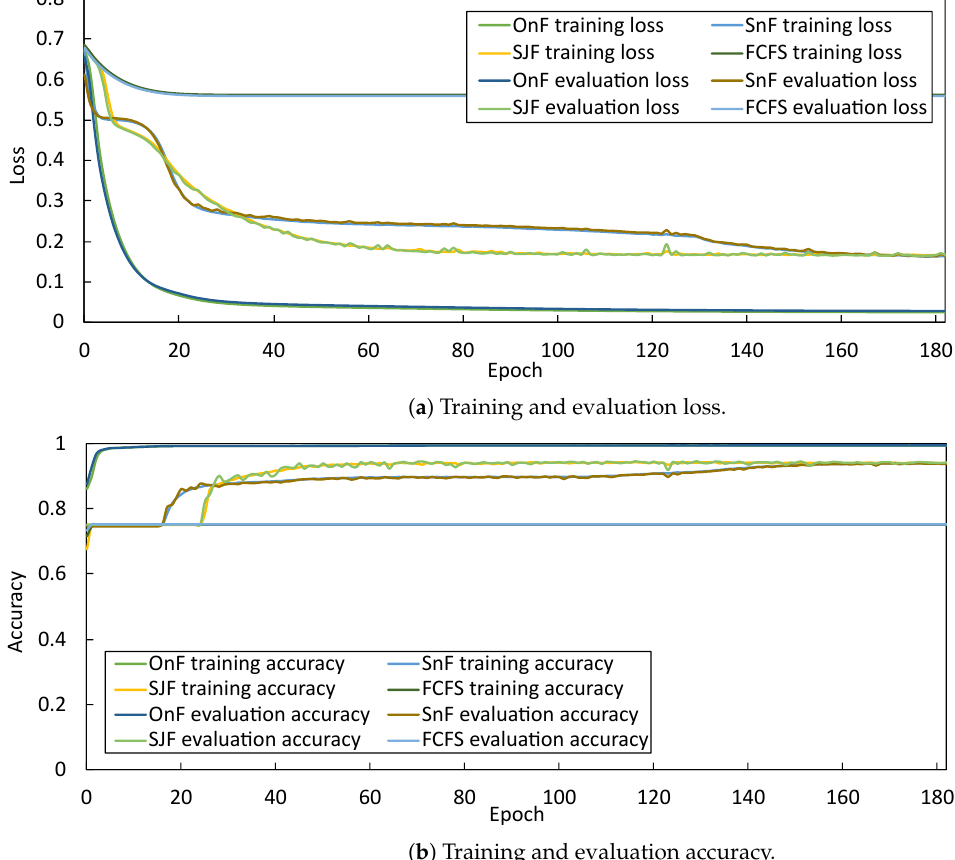
Figure 7. Plotted loss and accuracy from the post-training log on the generated